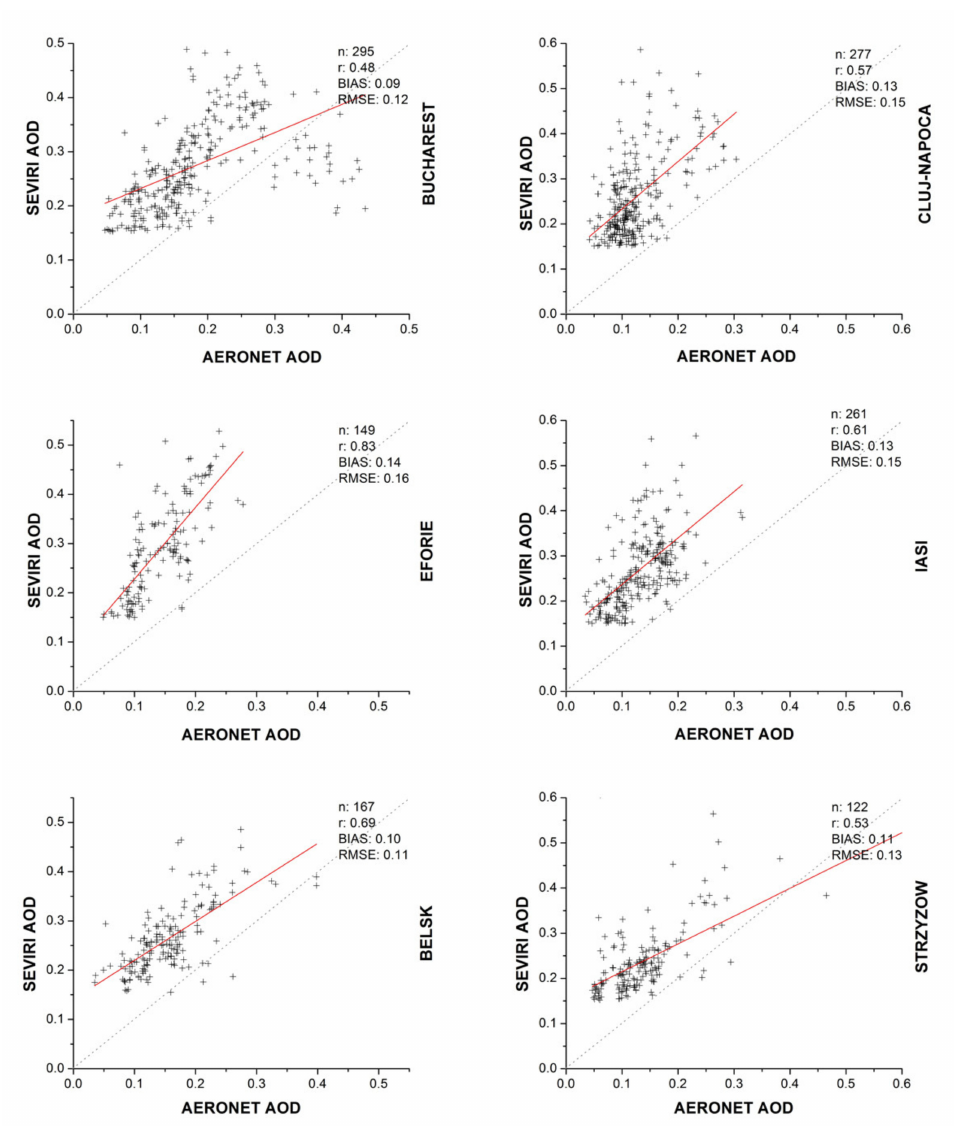
Figure 2. Correlation plots of the AOD (675 nm) measured in the Romanian AERONET sites in Bucharest, Cluj-Napoca, Eforie and Iasi, and Polish AERONET sites in Belsk and Strzyzow versus the SEVIRI AOD pixel (635 nm) derived for these locations during the period of June–September 2014. The red line shows linear